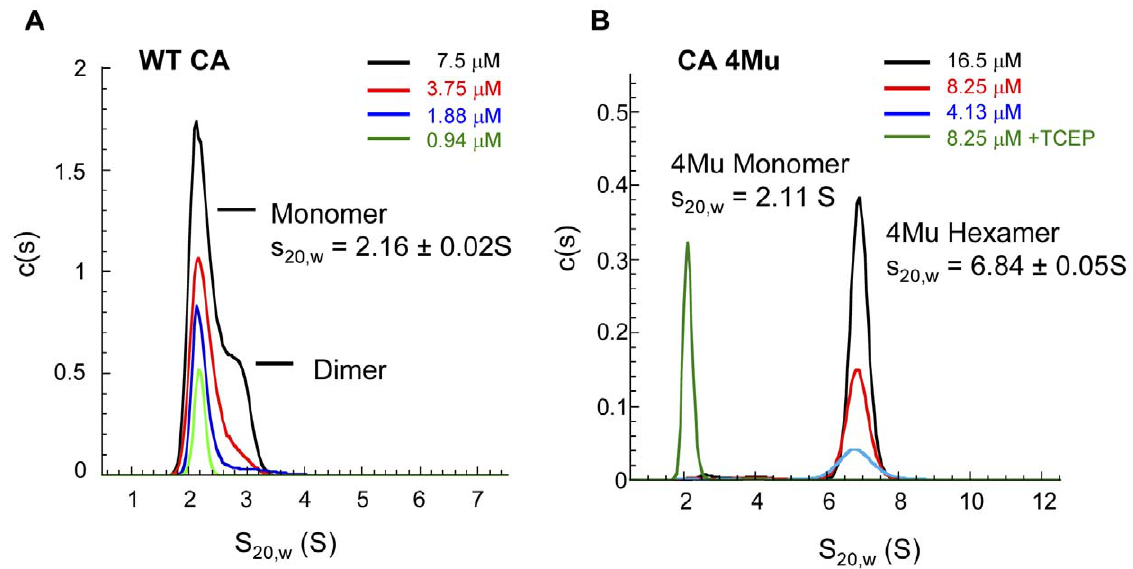
Figure 2. Solution oligomeric state of functionally purified WT CA and assembled CA 4Mu hexamer. ( A ) Full-length wild-type capsid protein (WT CA) and ( B ) hexameric capsid construct obtained by disulfide cross-linking of CA 4Mu monomer ([A14C,E45C,W184A,M185A]CA). Sedimentation velocity experiments were performed in 50 mM sodium phosphate buffer (pH 7.5) at 25 u C and 45,000 rpm. Absorbance scans at 280 nm were collected for CA FL ( A ) at 0.94 m M, 1.88 m M, 3.75 m M, and 7.5 m M, and for CA 4Mu Hexamer ( B ) at 4.13 m M, 8.25 m M ( 6 1 mM TCEP) and 16.5 m M (expressed as monomers of CA 4Mu). Sedimentation coefficient distribution – c(s) - was calculated using Sedfit program. WT CA contains monomers in equilibrium with dimers, whereas CA 4Mu hexamer preparation contains 94% of 4Mu monomers in hexameric form and 6% as a mixture of monomers, dimers and trimers. Treatment with 1 mM TCEP converts hexamers back to 4Mu CA monomers.